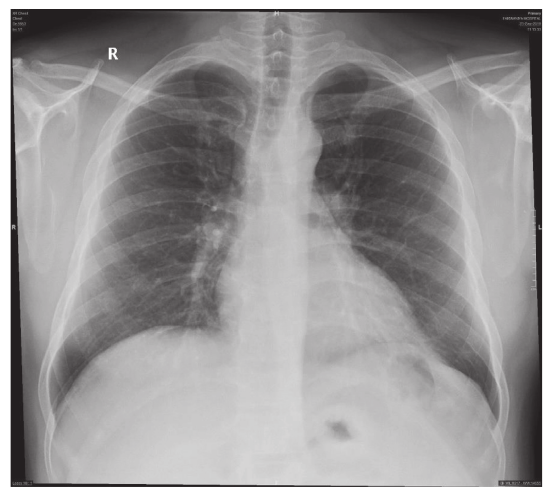
Figure 1: Preoperative chest radiograph for the patient showing normal lung fields with mild increase in bronchocovascular markings on the right lung.